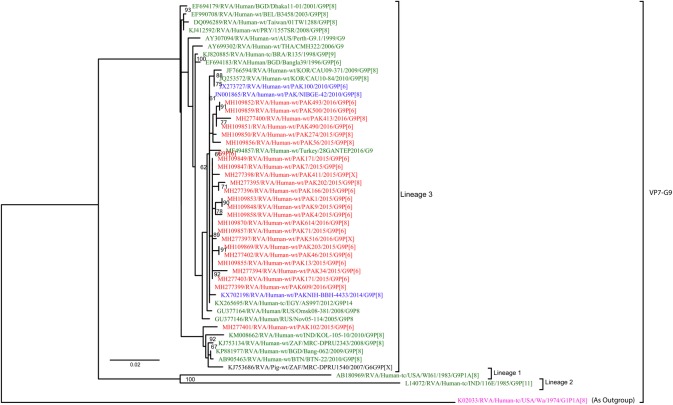
Maximum likelihood phylogenetic tree constructed from the nucleotide sequences of G9-VP7 strains and representative RVA strains with kimura-2-parameter model in MEGA program 6.0.Bootstrap values <60 are not shown. RVA strains sequenced in this study are represented by the red colour. Pakistani Strains reported in the previous studies are shown in blue. The out group strain is represented by purple colour, Pig strain is represented by Black Colour while green shading represent strains isolated in all over the world. Scale bar: 0.02 substitutions per nucleotide. The RVA strains sequenced in this study and reference strains obtained from GenBank database are represented by Accession number, Strain Name, Country and year of Isolation. Scale bar: 0.02 substitutions per nucleotide.